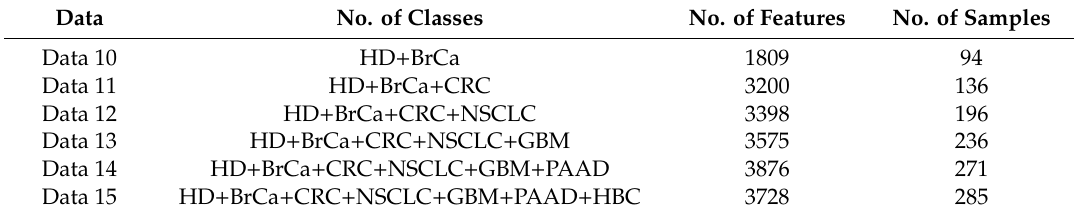
Table 2. Descriptions of the platelets